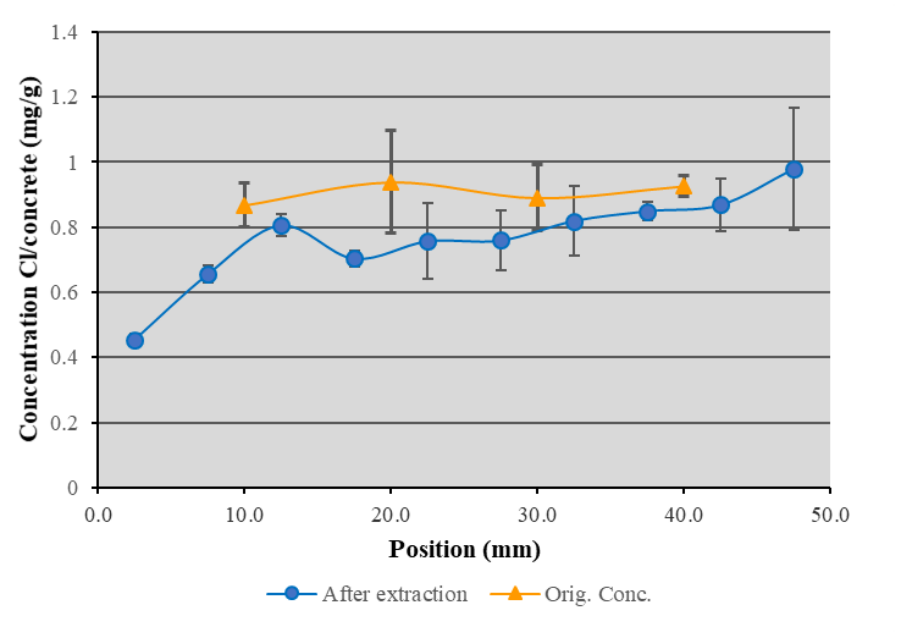
Figure 5. Concentration profile of L-1% samples before and after